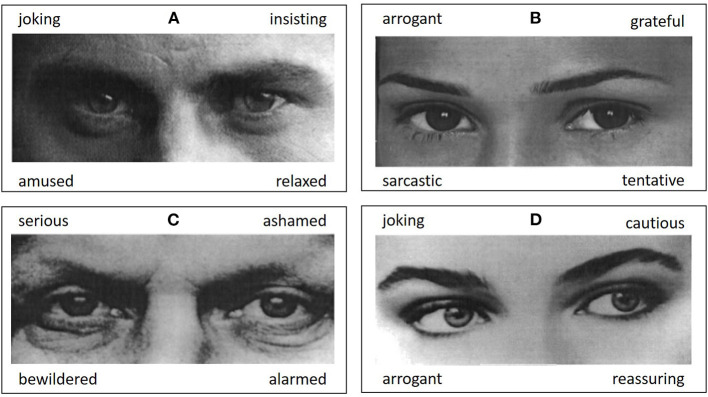
Figure shows example items from the Reading the Mind in the Eyes Test (Baron-Cohen et al., 2001; Bölte, 2005). Out of four response options the most appropriate mental state term shall be selected. Correct responses are (A) insisting, (B) tentative, (C) serious, (D) cautious. Pictures are taken from Bölte (2005).